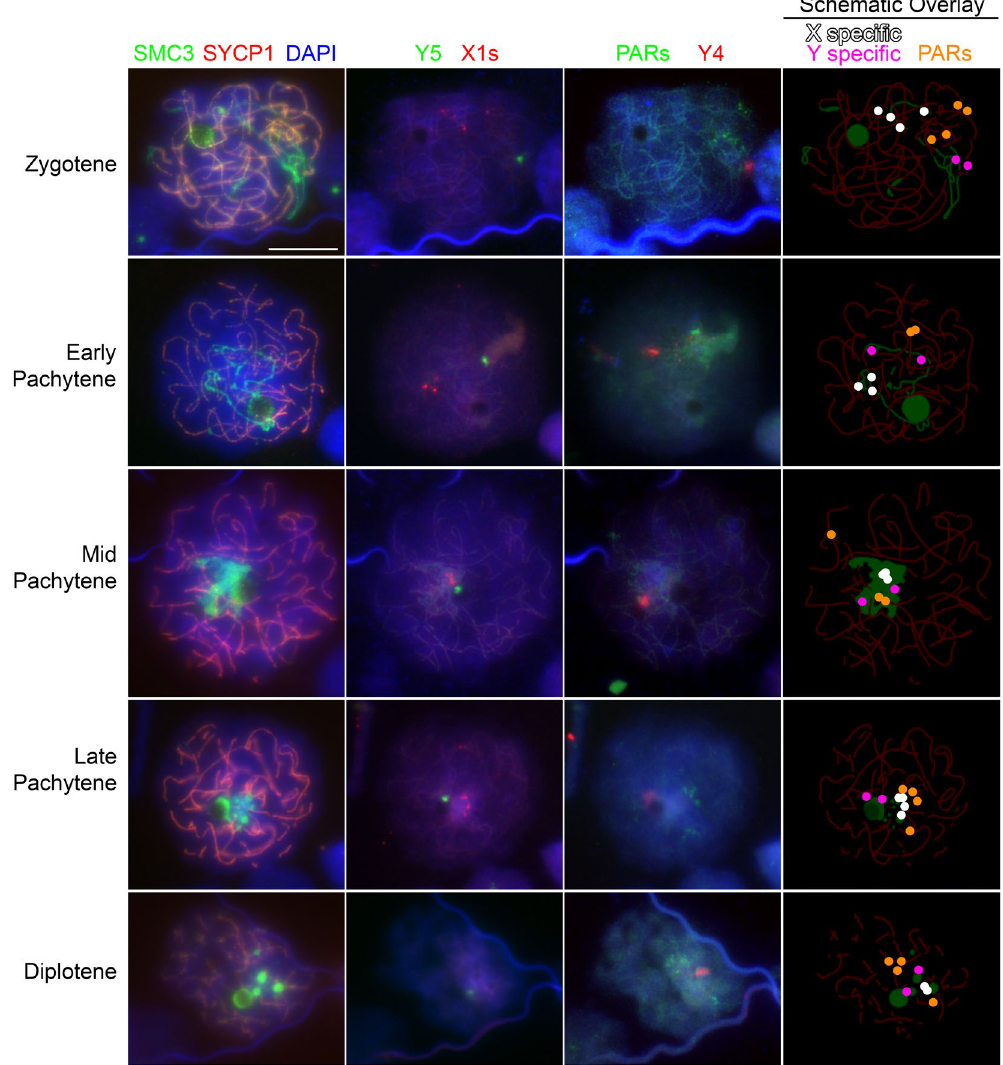
Figure 7. Sex chromosome localisation during prophase I. Four X 1 probes, a Y 5 probe, a Y 4 paint and four PAR probes are visible in each of the stages. From zygotene to pachytene, the X and Y specific probes localise to regions that have only SMC3 labelling, but no central element staining. Importantly in mid pachytene, no X or Y specific signal extends to a region outside of that which has increased SMC3 accumulation. In contrast, the PAR probes consistently localise outside of this region and localise over, or adjacent to, central elements. In diplotene, the X and Y specific probes localise to regions adjacent to, but not within, protein bodies containing SMC3, while the PAR probes localise to regions over, or adjacent to, central elements. Scale bar = 10 µ